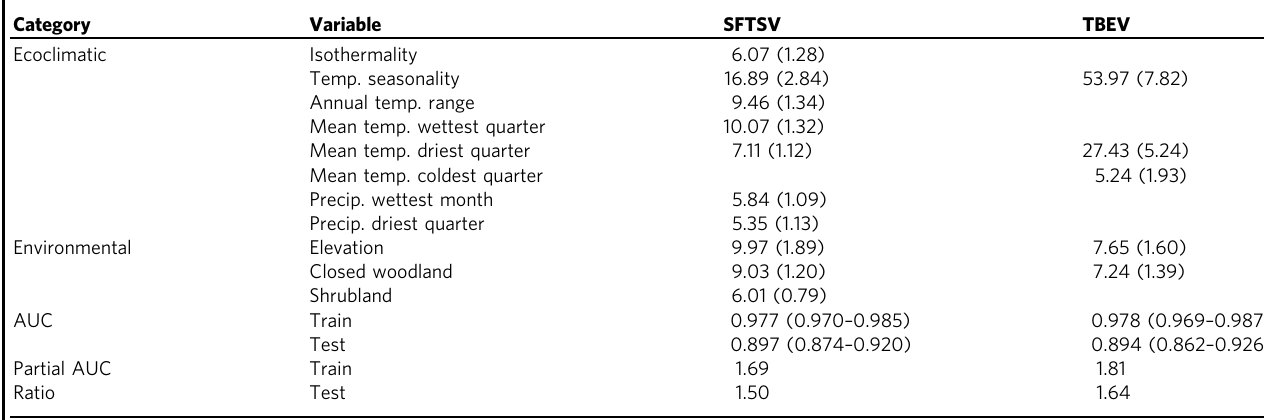
Table 2 BRT-model-estimated mean (standard deviation) relative contributions of major ecoclimatic and environmental factors (RC ≥ 4%) to the spatial distributions of SFTSV and